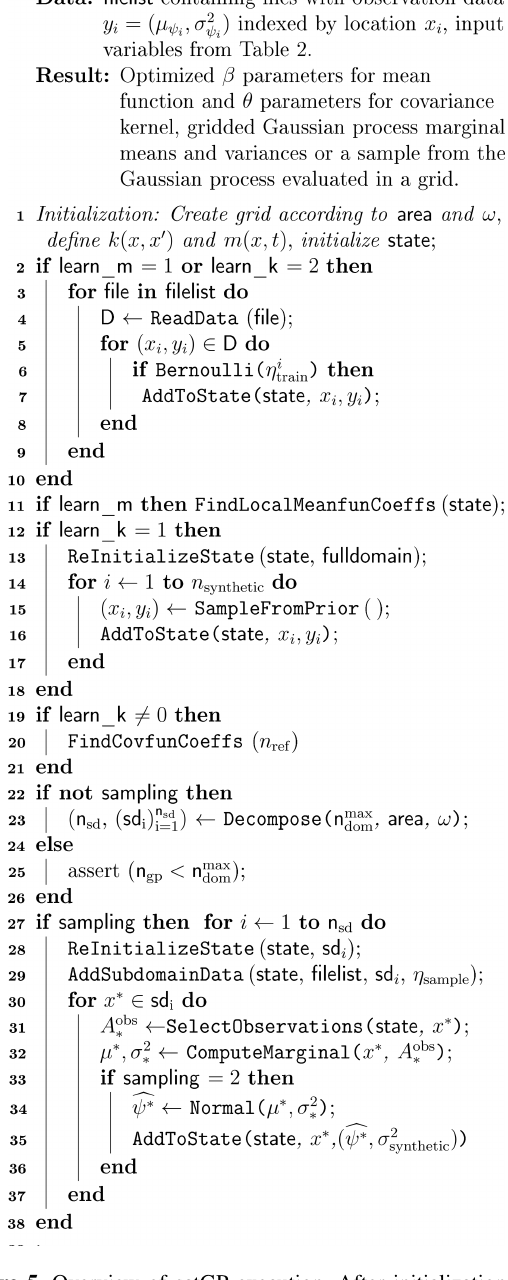
Figure 5. Overview of satGP execution. After initialization, data are read for training m and k , and possible MRF computation is car- ried out. This is followed by sampling the prior if a synthetic study is performed and learning the θ parameters controlling k . Gaussian process marginals are then computed in a grid, potentially by de- composing the domain for large grids. Finally, samples from the GP may be drawn. The names of the subprograms here deviate from those in the code to improve